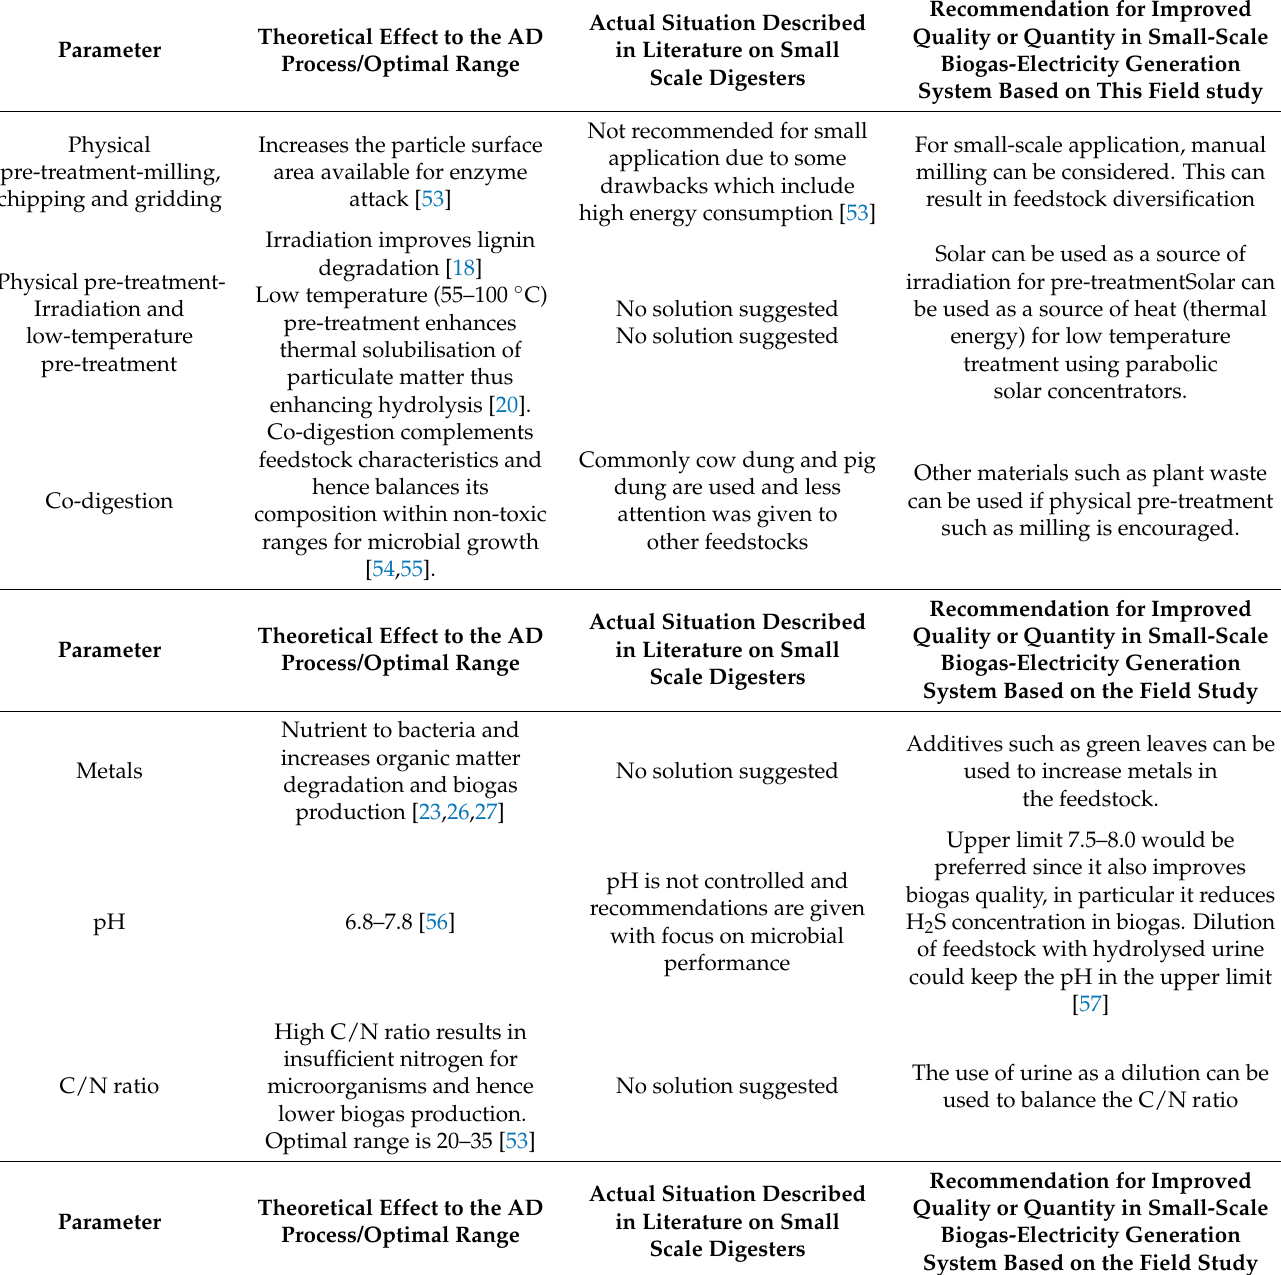
Table 2. Effect of operational parameter on AD and their optimal